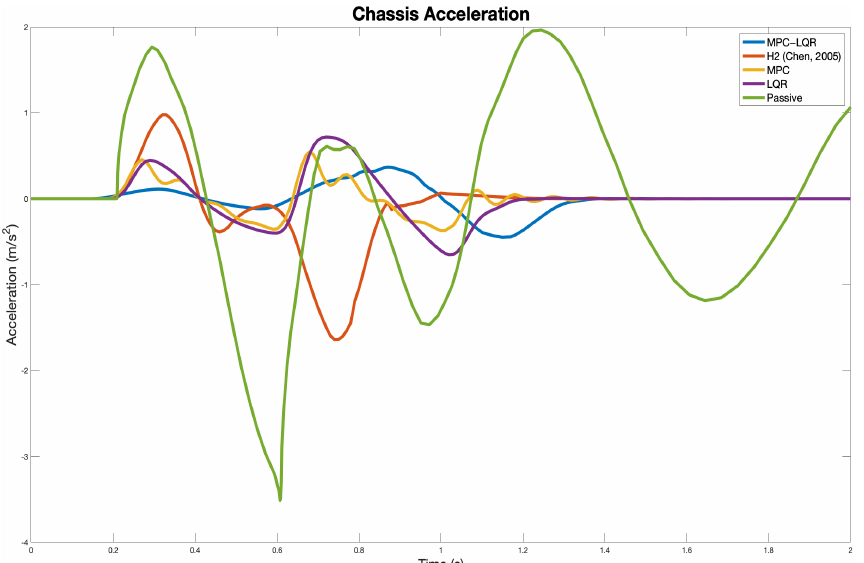
Figure 6. Chassis acceleration (Blue—MPC-LQR, Red—H2, Yellow—MPC, Purple—LQR, Green— Passive).